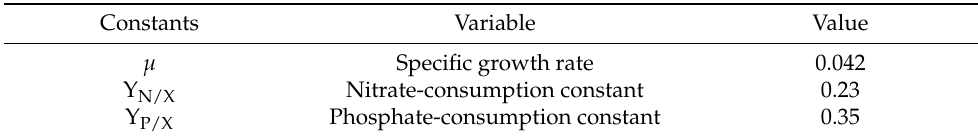
Table 2. Kinetic variables from the experimental culture of Chlorella sp.